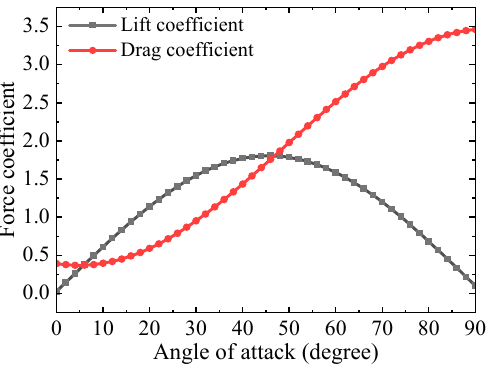
Figure 14. Translational lift and drag coefficients calculated based on the research by Dickinson et al. [1].